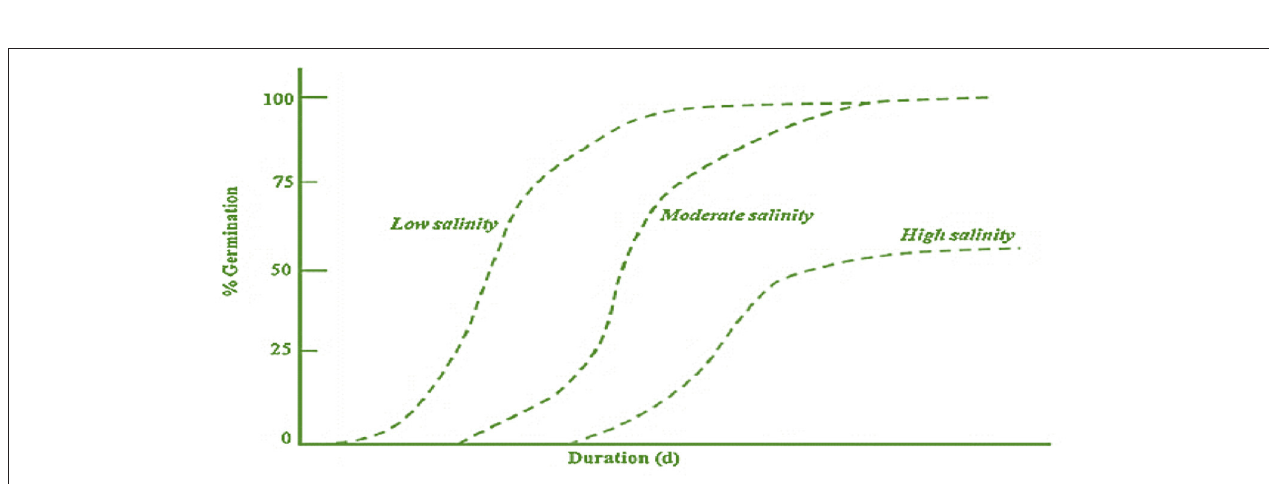
FIGURE 2 | Association between germination rate and exposure duration after sowing at different salinity levels (low, moderate, and high) (Source: Läuchli and Grattan, 2007).